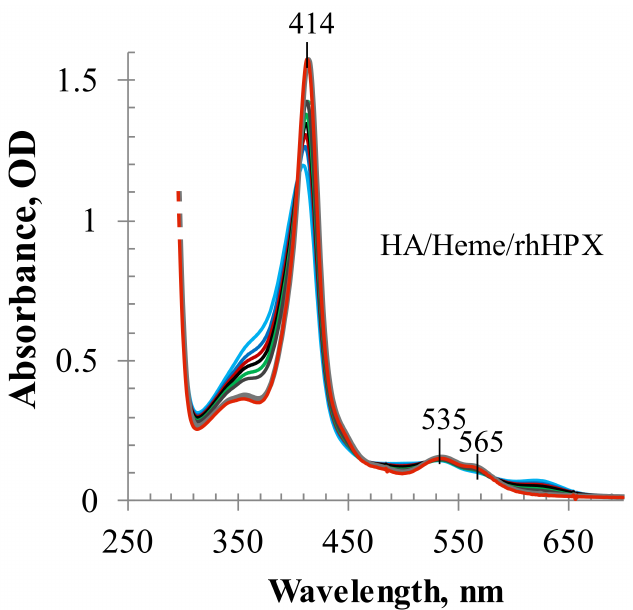
Figure 3. UV-Vis spectra of heme transfer from methemalbumin (HA/Heme) to rhHPX monitored Figure 3. 3. for 10 min after adding rhHPX (light blue trace corresponds to 1 min, and red trace—to 10